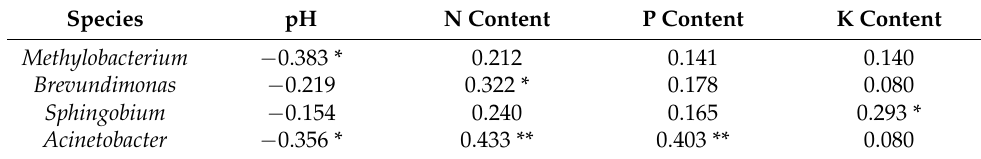
Table 5. Correlation analysis between key bacteria and soil chemical